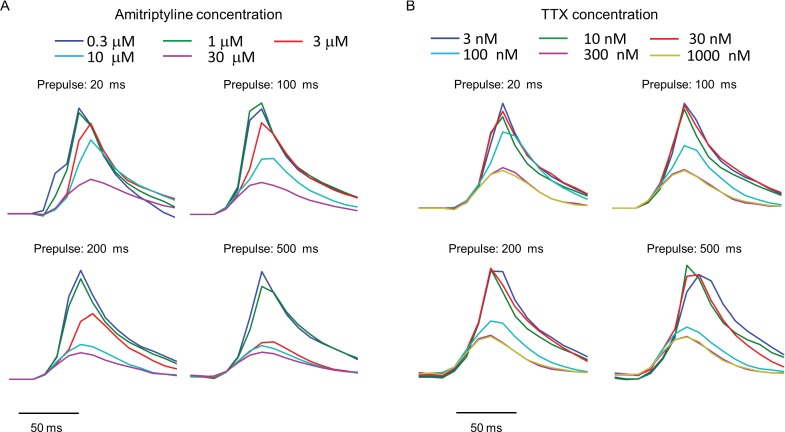
Use-dependent inhibition of NaV1.7 by amitriptyline and TTX.Data used to produce Figures 3C,D. Plots show the fluorescence response evoked by the test pulse with variable duration prepulses. Each trace is the average of n = 3–5 wells for amitriptyline or n = 4–6 wells for TTX.